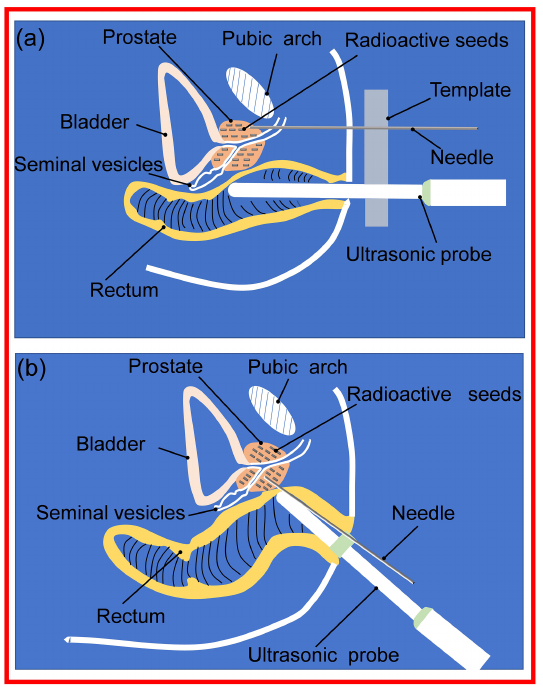
Figure 1. Prostate BT via (a) transperineal and (b) transrectal ac- cess.